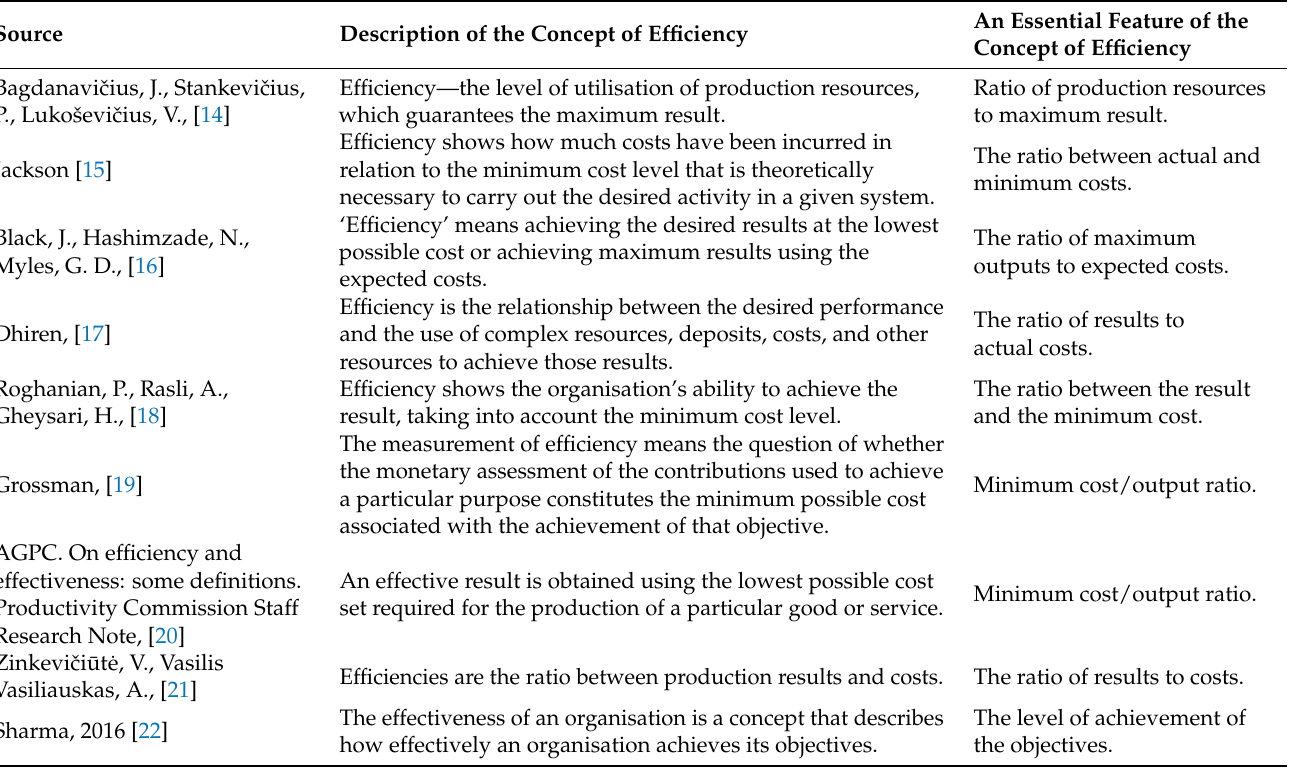
Table 1. Description of the concept of efficiency